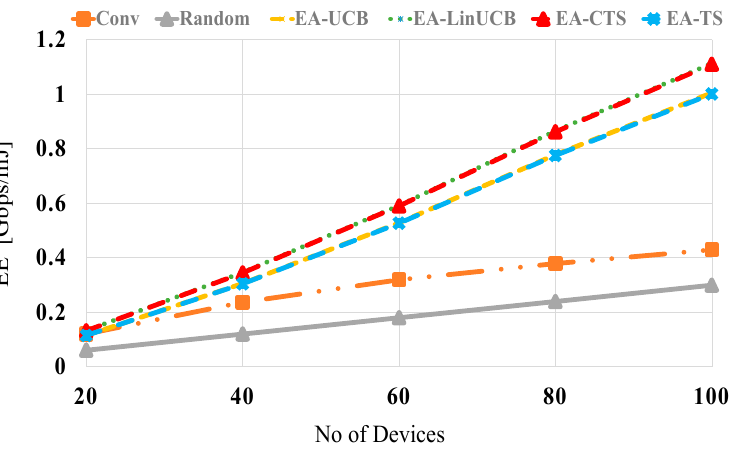
Figure 8. EE versus the number of devices for EA-UCB, EA-TS, EA-LinUCB, and EA-CTS at no blocking.